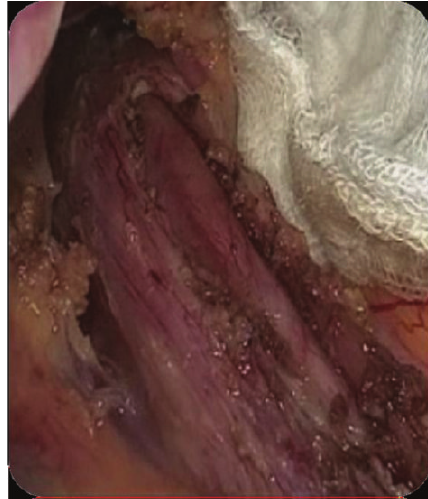
Figure 3: Laparoscopic Heller’s myotomy.